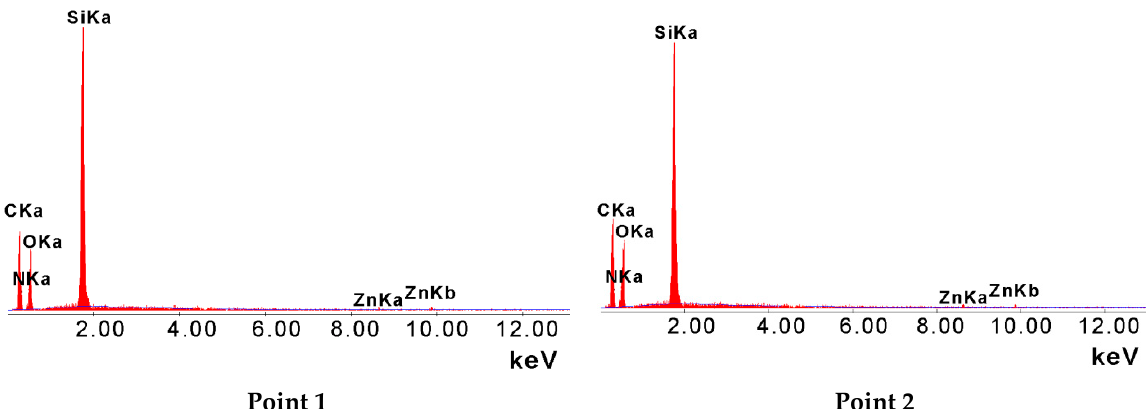
Figure 2. EDX spectrum of the hybrid gel sample referring to two points 1 and 2 depicted in Figure 1.